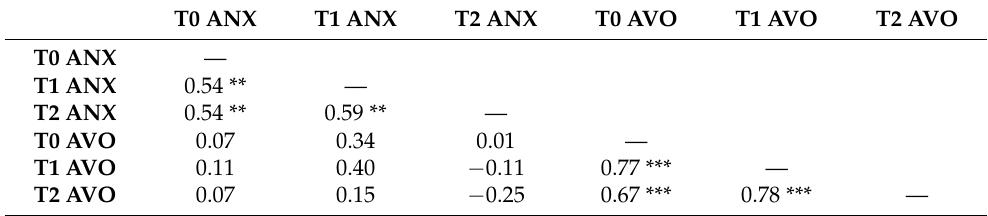
Table 2. Pearson Correlation Coefficients between Attachment Insecurity at T0, T1, and T2. T0 ANX